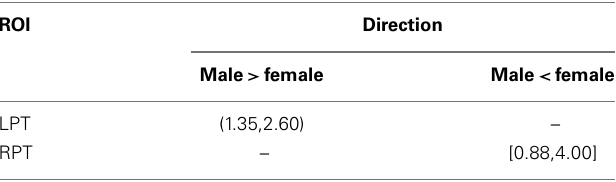
Table 5 | Censored significant p -value regions for the LCDM distances compared by gender